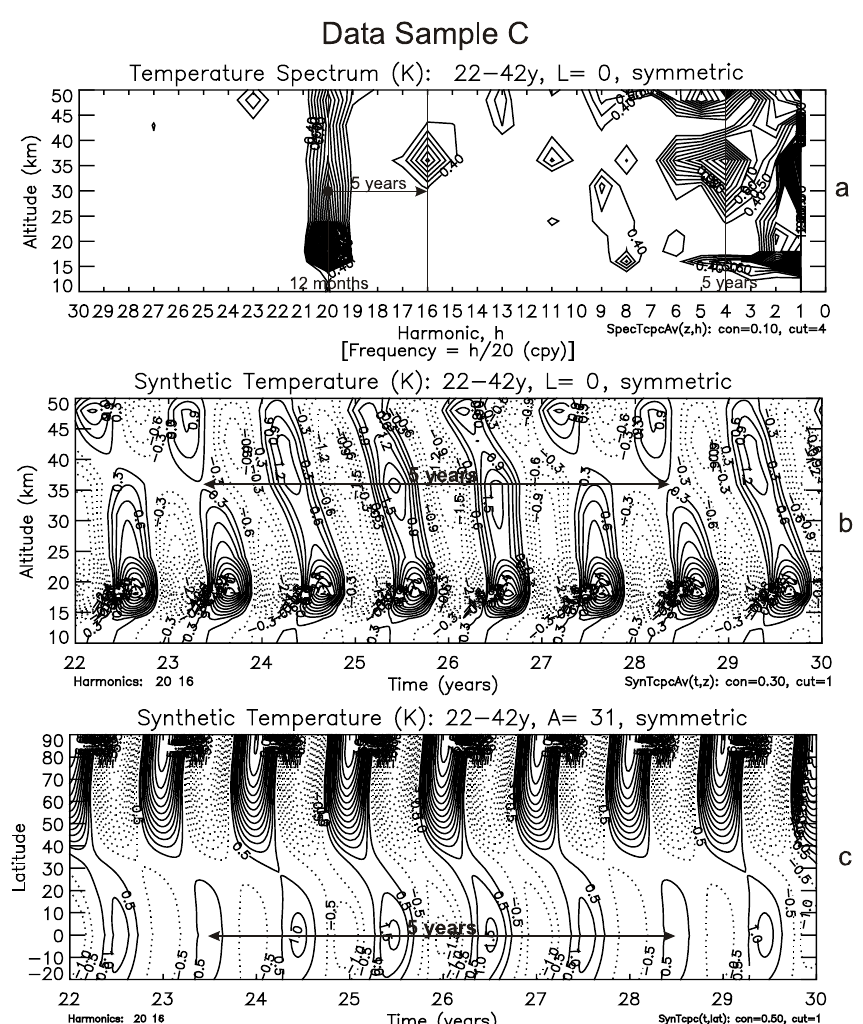
Fig. 4. Sample C (defined in Fig. 2b) of CPC temperature data. (a) Symmetric temperature spectrum for 0 degrees latitude and from 10 to 50km altitude show the AO at h=20 and the side lobe at h=16 to indicate a pronounced 5-year modulation that peaks near 35km, analogous to the wind results in Figs. 1 and 3. (With contour intervals of 0.1K, the lowest 3 levels are suppressed to eliminate clutter.) (b) Synthesized variations versus height show the relatively large 5-year modulation at 35km. The oscillation slowly propagates down, presumably due the efficient hemispherically symmetric wave forcing near the equator. (a) Synthesized latitudinal temperature variations of 5-year AO at 31km, which are almost in phase with the corresponding zonal wind modulations at 26km shown in Figs. 1c,